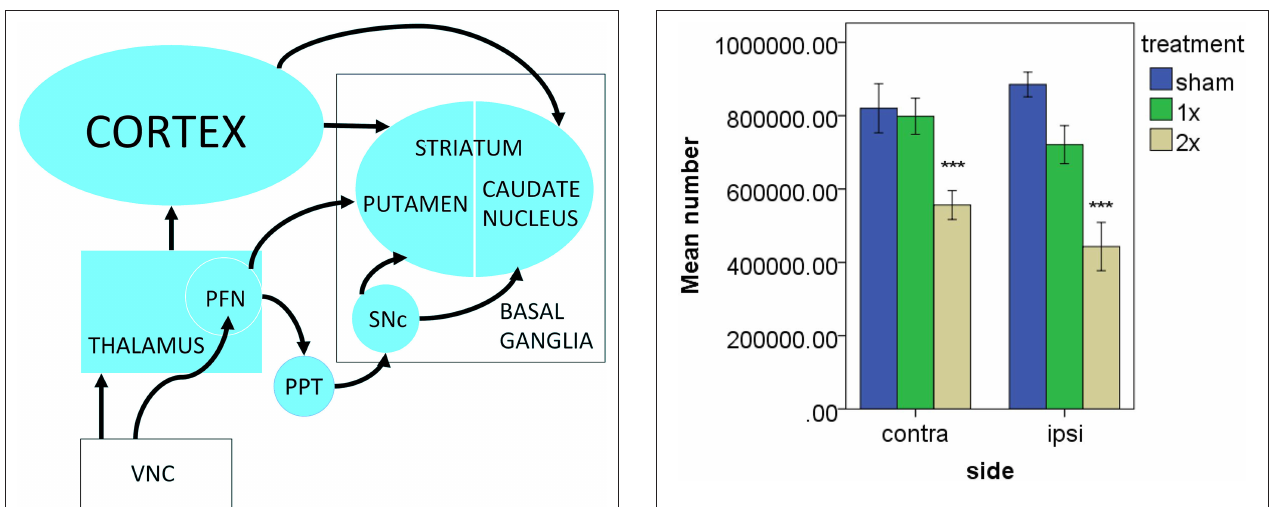
FIGURE 2 | Estimated number of c-Fos positive cells in the striatum following vestibular stimulation. *** P ≤ 0.0001 for the comparison of the higher current with both the sham groups and the lower current group. From Stiles et al. ( 59) with